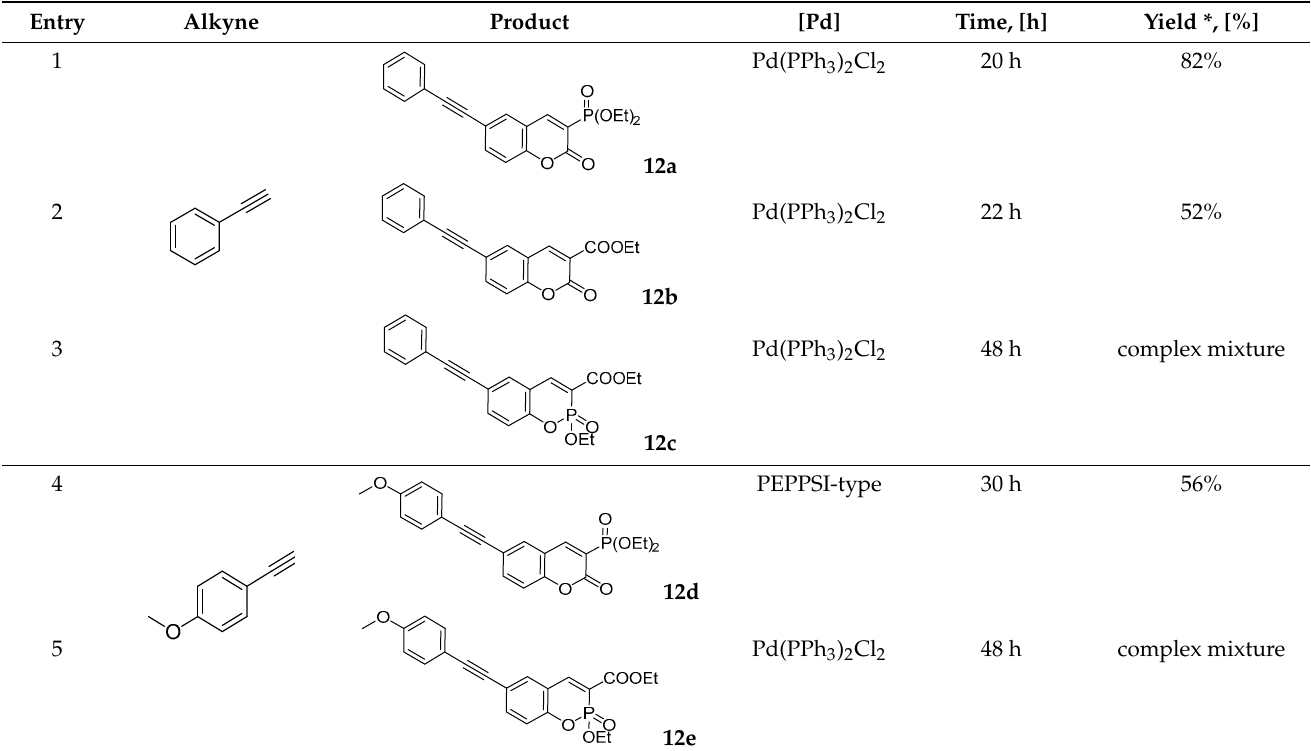
Table 6. Parameters, reagents, and products of palladium-catalyzed alkynylation of 3-substituted coumarin species—Sonogashira reaction.